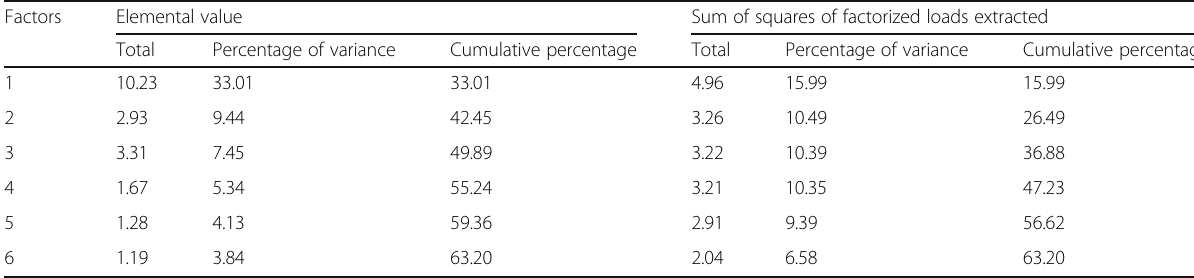
Table 3 The total variance explained by the six-factor model